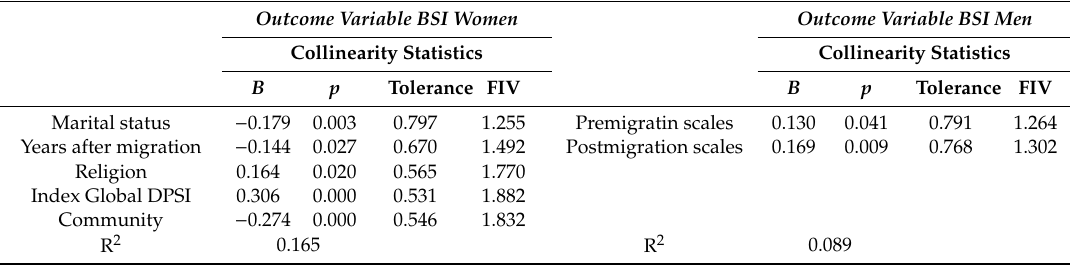
Table 4. Hierarchical lineal regression (enter) of psychological distress disaggregated by gender.